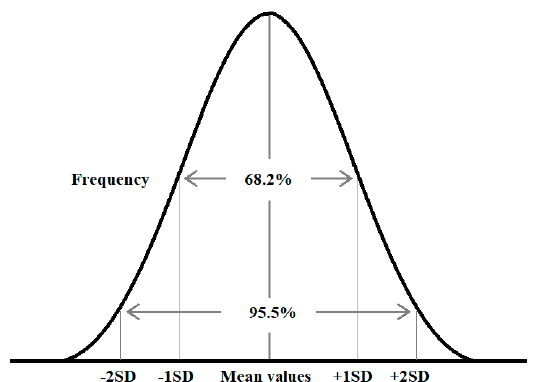
Figure 2. Gaussian distribution showing percentage of values within a certain standard deviation from the mean (own elaboration based on [73]).